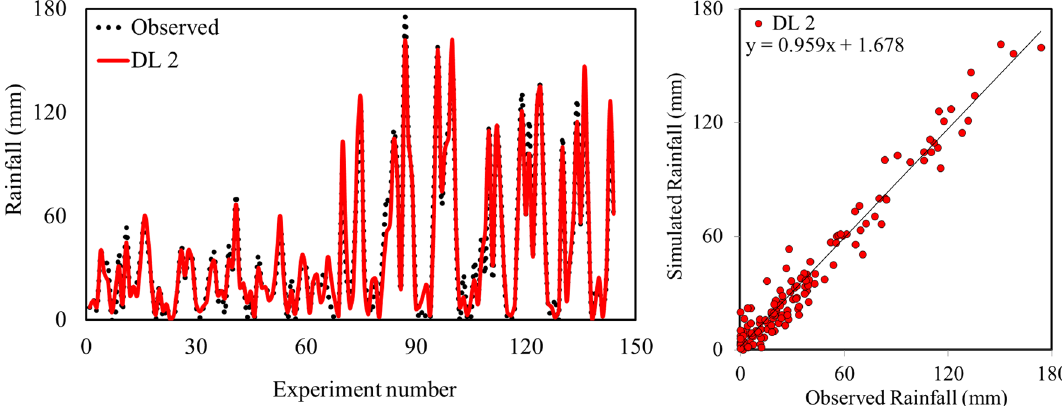
Fig. 8 Comparison of rainfall amounts simulated by DL 2 with observed